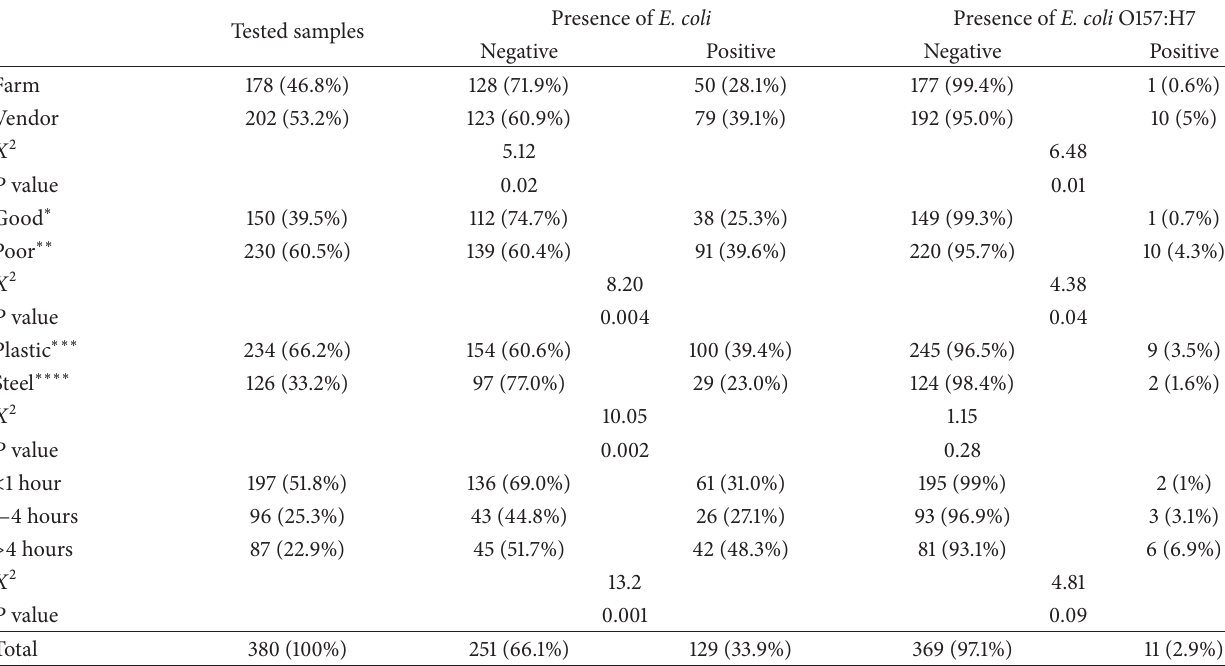
Table 1: Prevalence of E. coli in the study samples in different